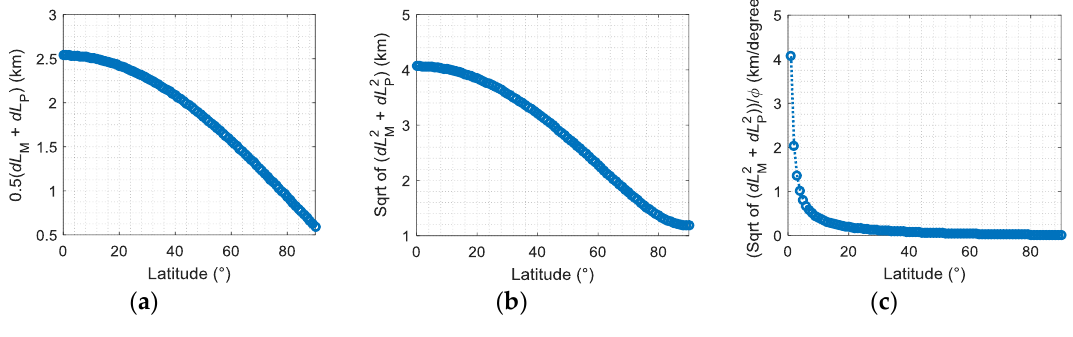
(cid:113) + dL 2 dL 2 , M P